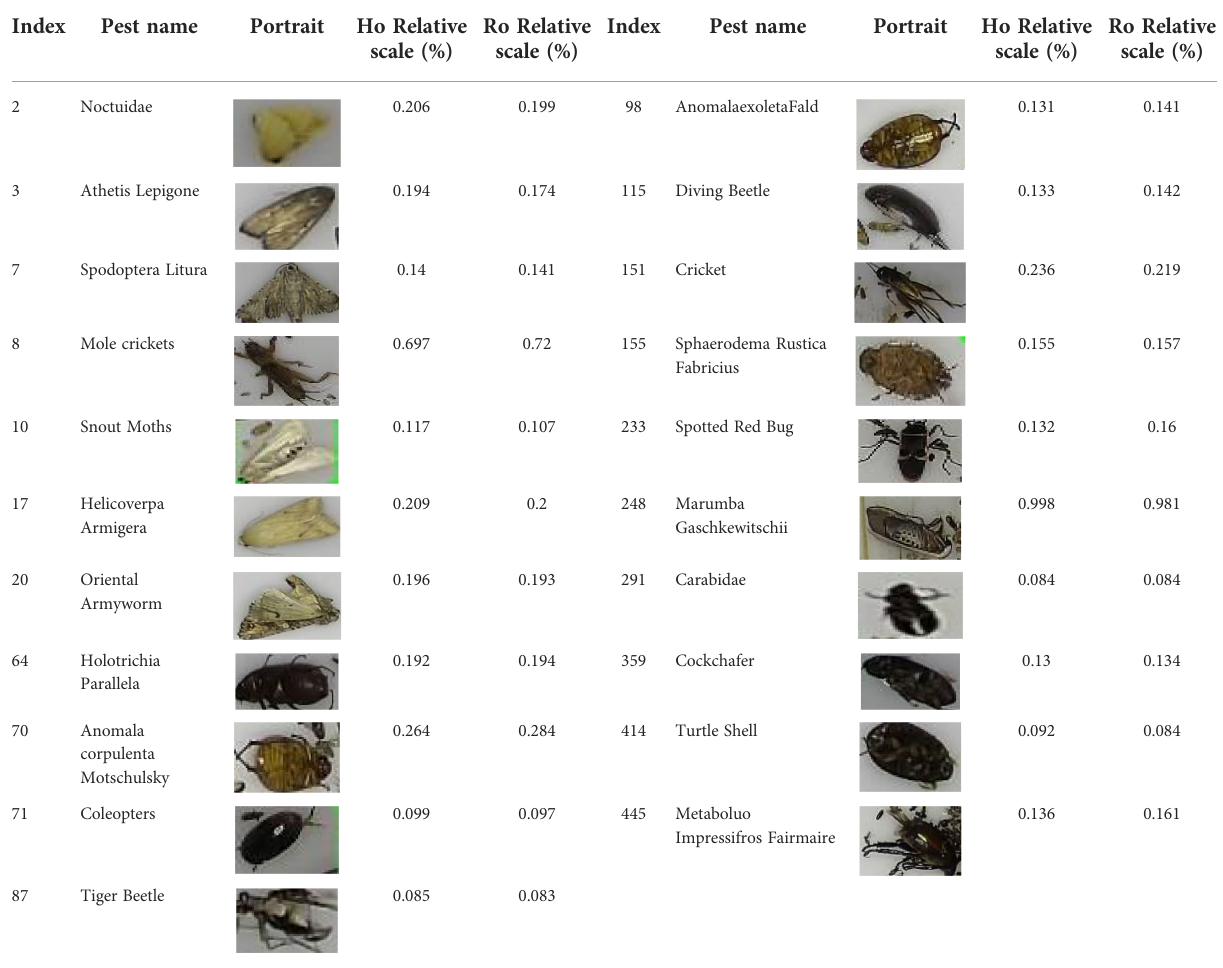
TABLE 1 The species of pests and the proportion of relevant